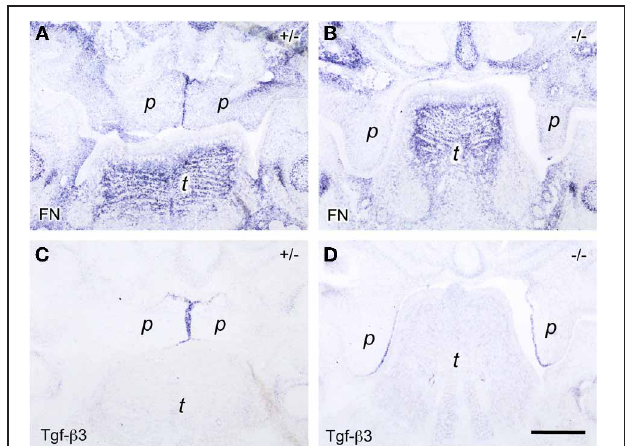
FIGURE 5 | In situ hybridization for tenascin-C (TNC; A,B) and tenascin-W (TNW; C,D) mRNA, respectively, on frontal sections through the heads of E13.5 (A,C) and E14.5 (B,D) wildtype mouse embryos (posterior level). Maxillary process ( mx ), palatal shelf ( p ), tongue ( t ). Bar, 250 μ